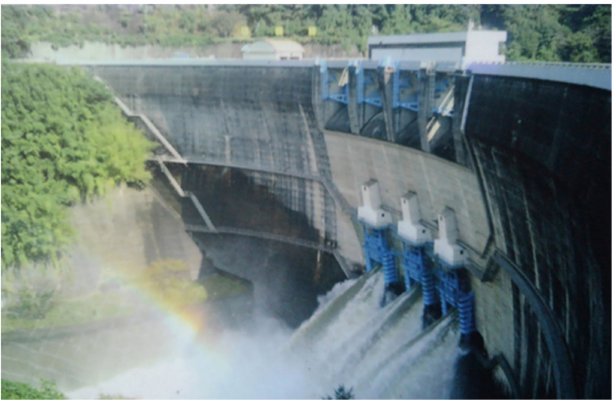
Figure 11. A photo of Amagase Dam (the dam height is 73 m, the dam width is 254 m). For the proposed dam-break simulation, the following information is required as input data sets; (1) assumed broken width and height, as listed in Table 2. (2) Proposed dam’s reservoir area, as listed in Table 2. (3) Water head behind the dam, as listed in Table 2. (4) Calculation meshes size, as listed in Table 2. Since the proposed model of Ca et al. [15] is based on the finite difference method (FDM), the mesh size limitation is always a concern which mainly depends on the capacity of the available computer, size of the proposed dam and required accuracy. (5) The existing topography contour map is shown in Figure 12. in trees ratio in a mesh (as shown in Figure 13, the light green color (the building ratio is 1 % in a mesh area) is referred to a soil and sand area, the dark green color (5 % in a mesh area) with a garden, the gray color area (70 % in a mesh area) shows a building area, (7) Grain